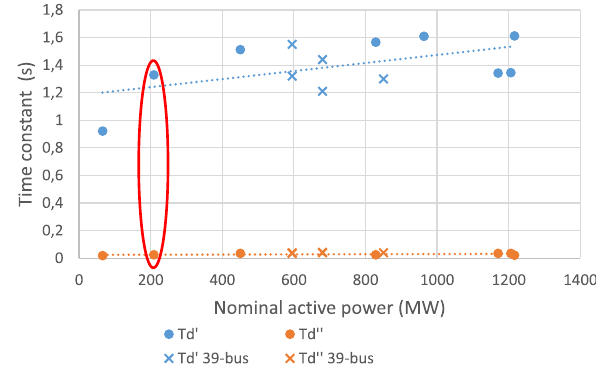
Fig. 9. Evolution of nuclear unit’s inertia constants as a func- tion of nominal active power in the 39-bus grid and according to [19].